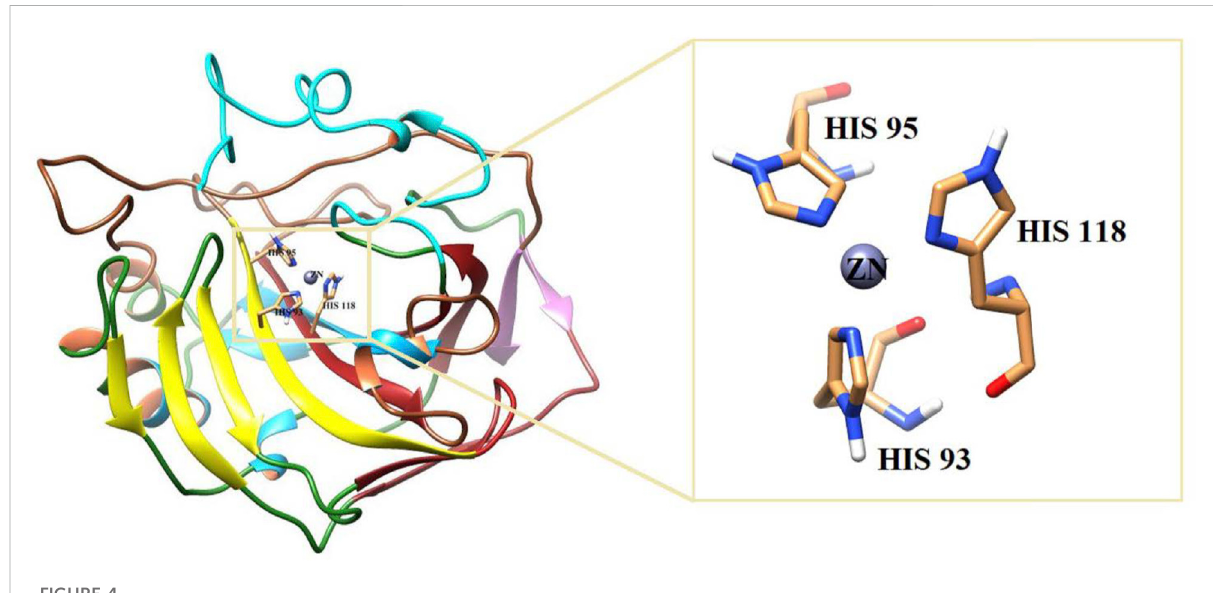
FIGURE 4 3D-structure of bCA is shown. The active site is highlighted in the box.